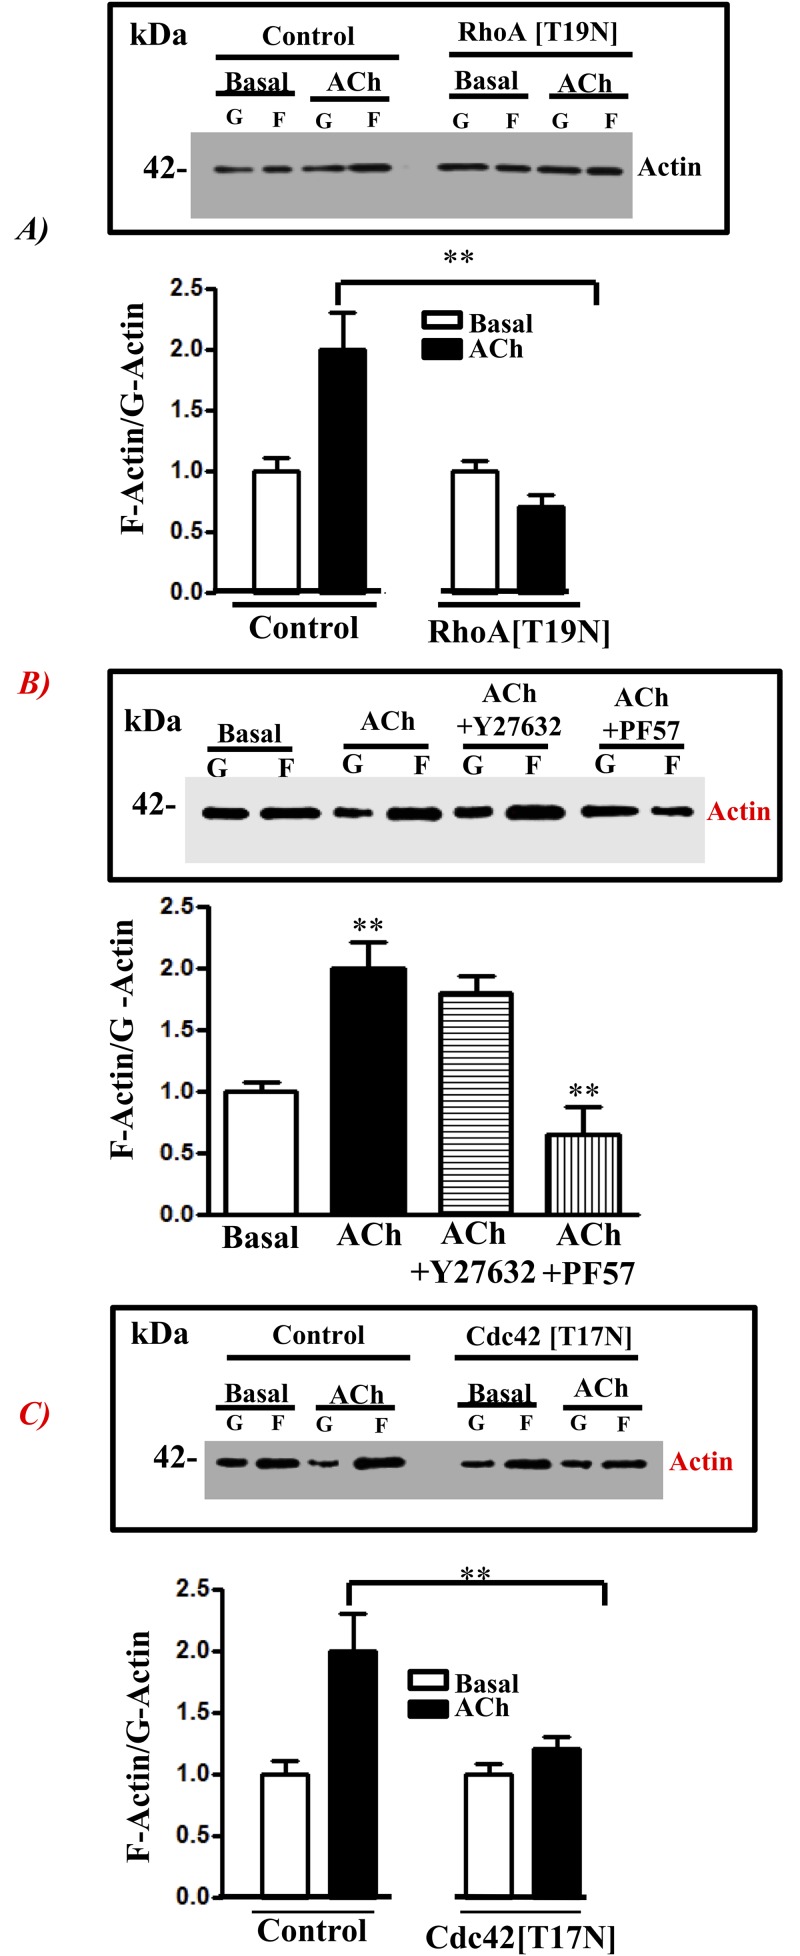
RhoA/FAK/Cdc42-mediated increase in sustained actin polymerization by ACh.A: Actin polymerization (F/G-actin) was measured by western blot using actin antibody. Cultured smooth muscle cells expressing either control vector or RhoA dominant negative (RhoA [T19N]) were treated for 10 min with 1 μM ACh. B: Cultured smooth muscle cells were pre- treated with the Rho kinase inhibitor Y27632 (10 μM, 10 min) or the FAK inhibitor PF573228 (10 μM, 1 h) followed by 1 μM ACh for 10 min. C: Cultured smooth muscle cells expressing either control vector or Cdc42 dominant negative Cdc42 [T17N] were treated for 10 min with 1 μM ACh. The results are expressed as densitometric values. Values are means ± SE of five to six experiments. **P<0.001.